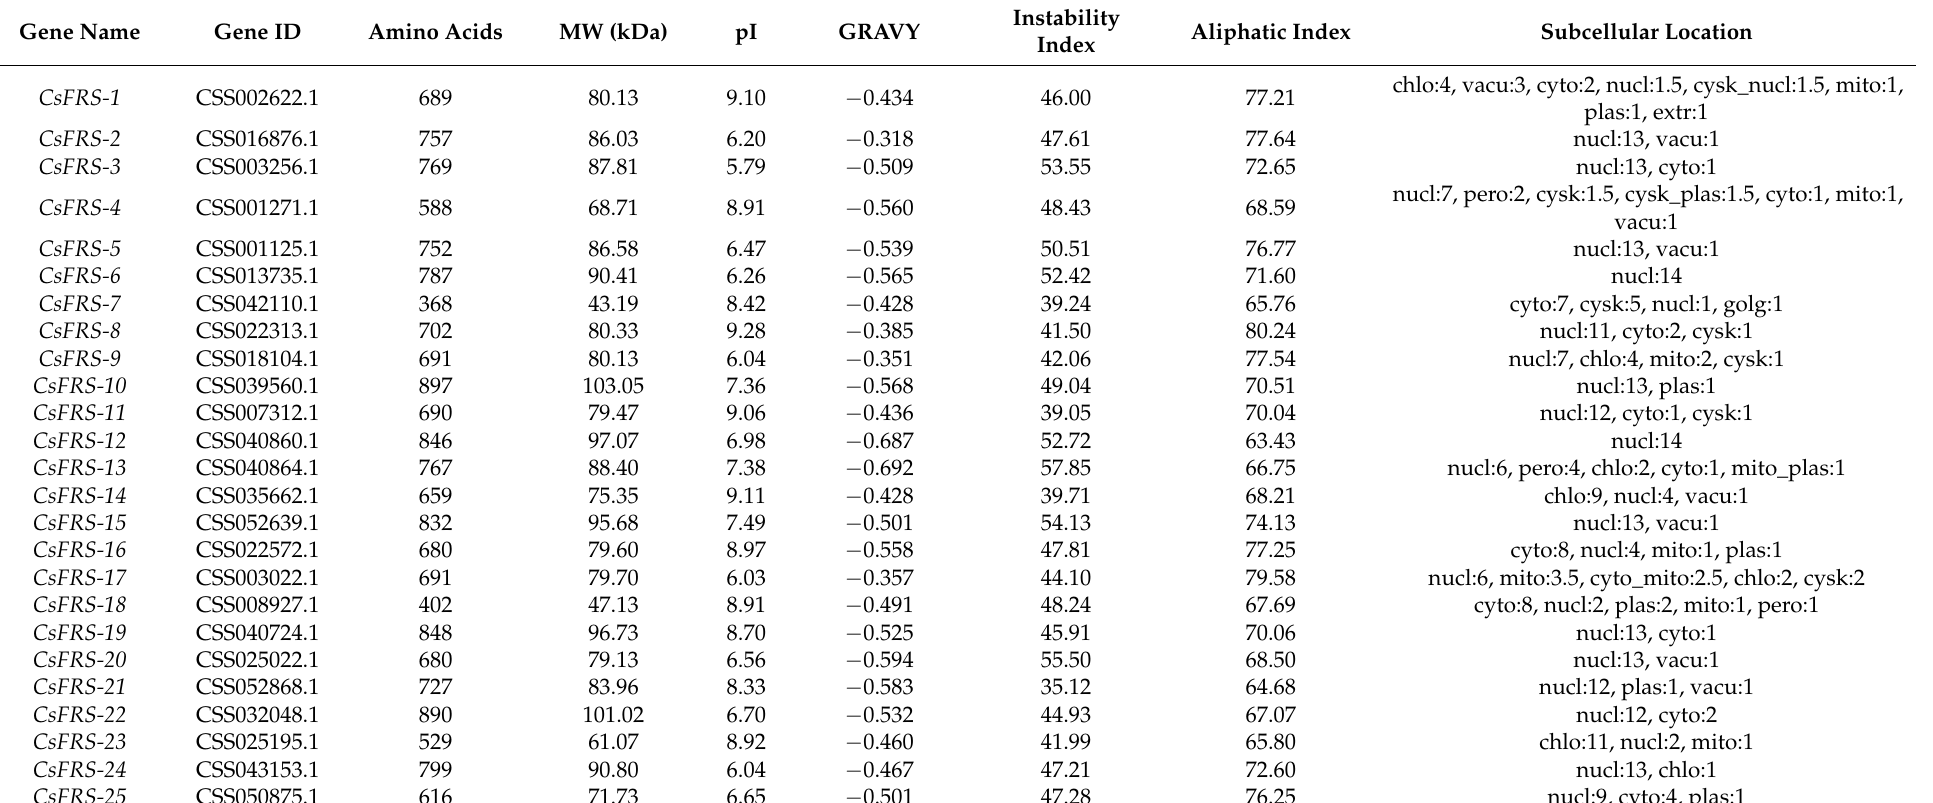
Table 1. Summary information of the physiological and biochemical properties of the